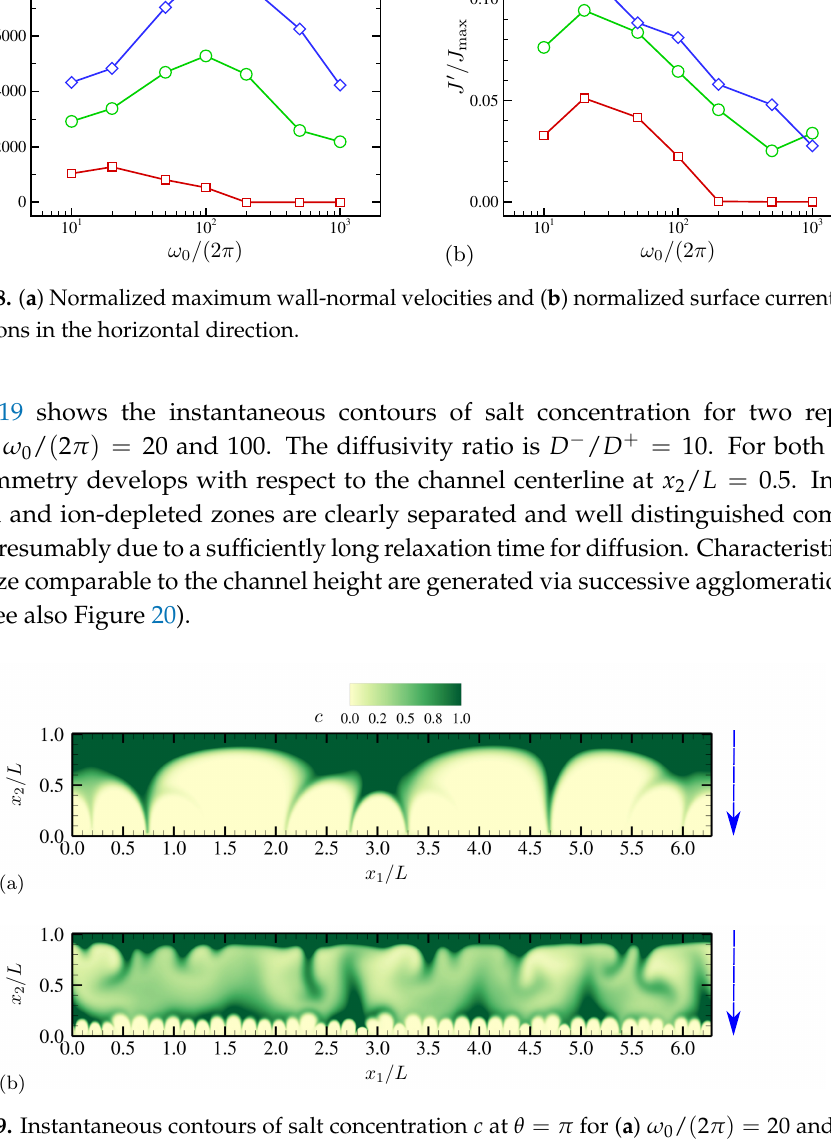
Figure 19. Instantaneous contours of salt concentration c at θ = π for ( a ) ω 0 / ( 2 π ) = 20 and ( b ) 100. The diffusivity ratio is D − / D + = 10, and the maximum applied voltage is ∆ V = 180. The vertical arrows denote the direction of the applied electric